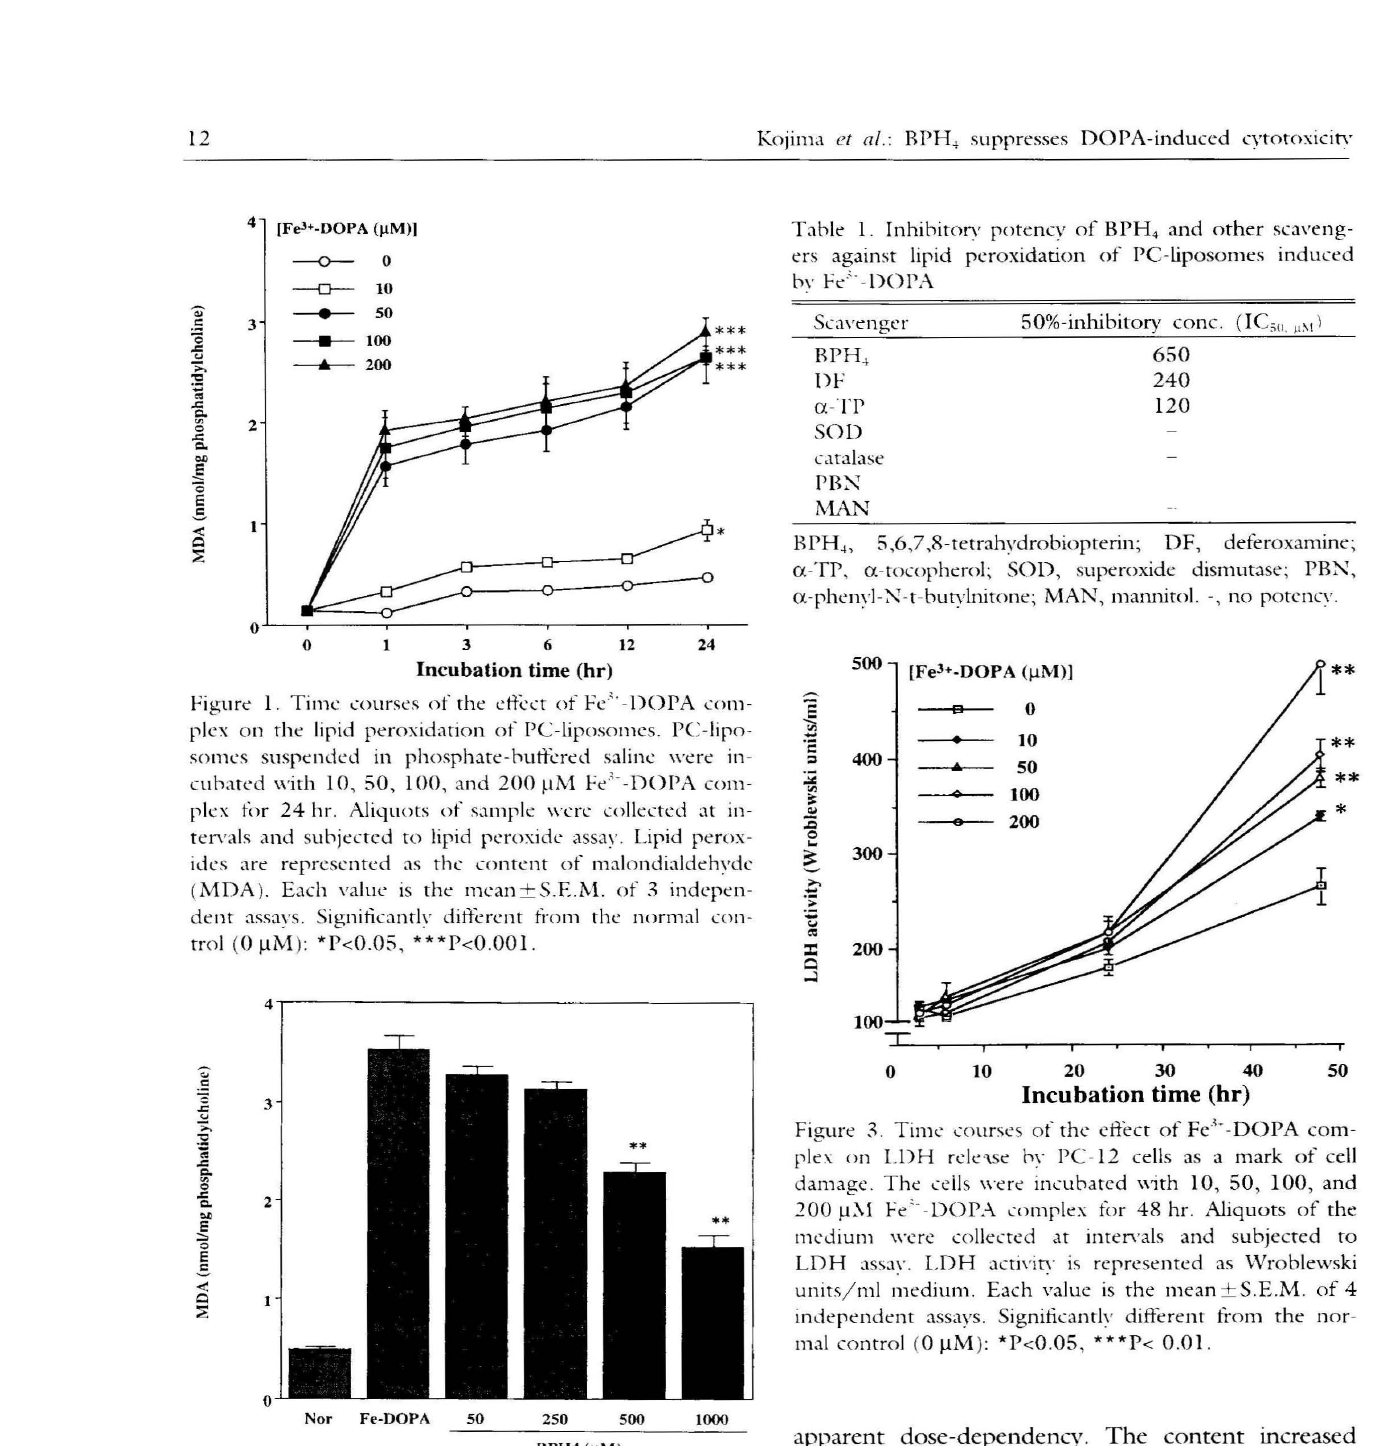
figure 2. Ett~cts of HPH. on the lipid peroxidation of PC-Iiposomes induced by fe 3 --DOPA complex. PC-lipo somes suspended in phosphate-buttered saline were in cubated with 50 pM Fe'--DOPA complex in the pre sence of BPH. for 3 hr, and lipid peroxide was assayed. Lipid peroxides arc represented as the content of malon dialdehyde (MDA). Each value is the mean ±S.E,M . of 3 independent assays. "Nor" indicates the control without fe 3 --DOPA. Significantly difrerent from re"--DOPA com plex-treated group: **1'< 0.01. MDA content were observed at concentrations of more than 50 11M Fe 3 +-DOPA complex, without Pteridines/ Vol. 8/ No. 1